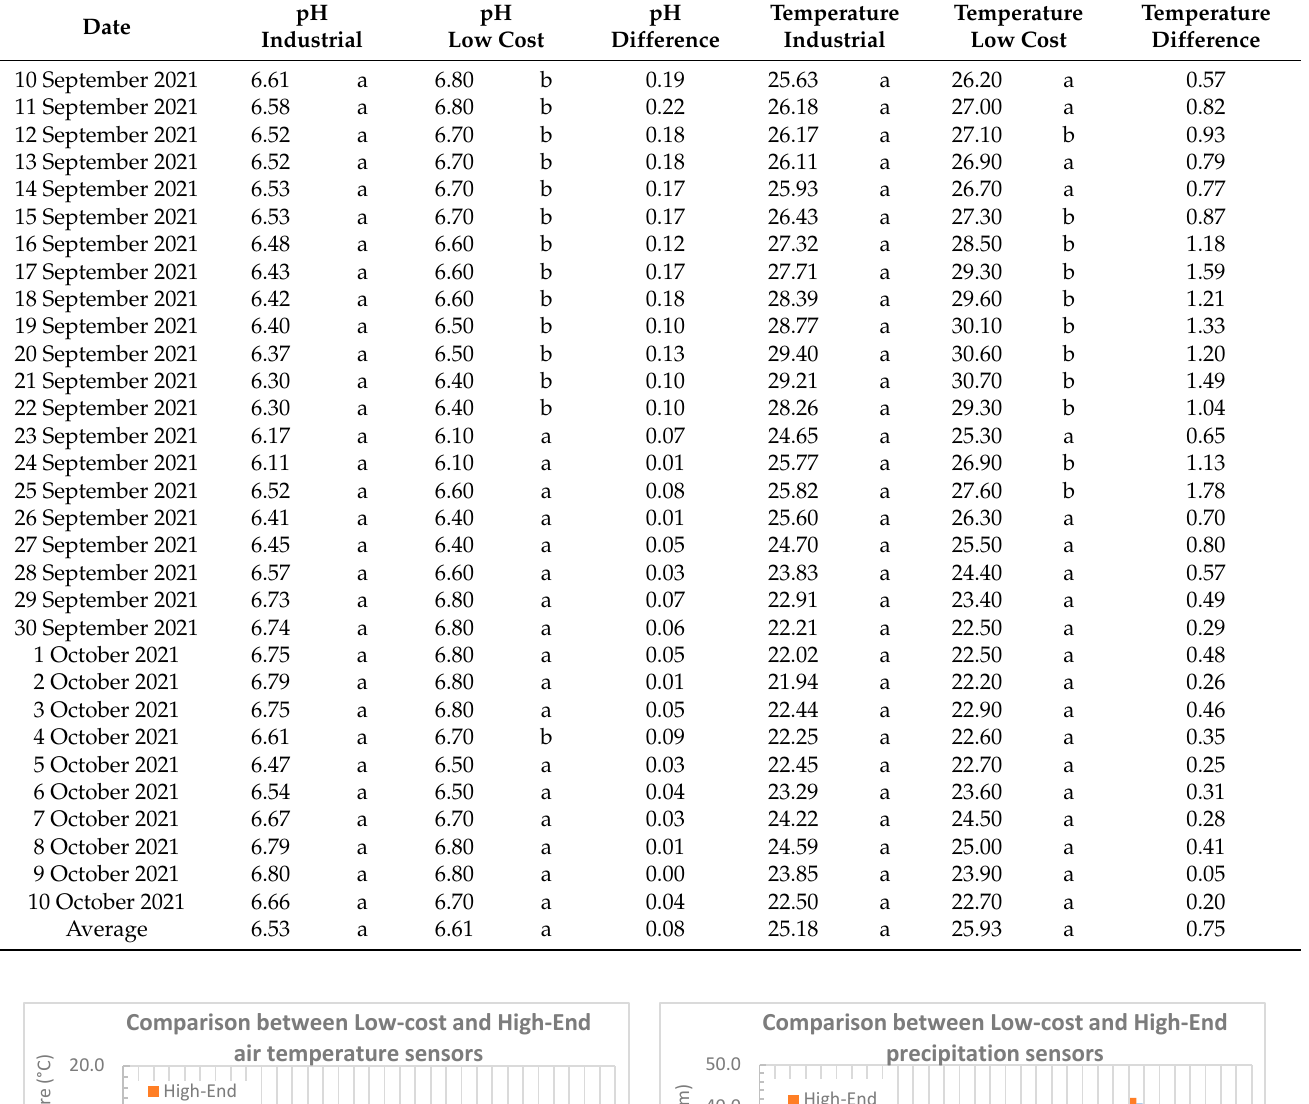
Comparison between Low‐cost and High‐End precipitation sensors High‐End